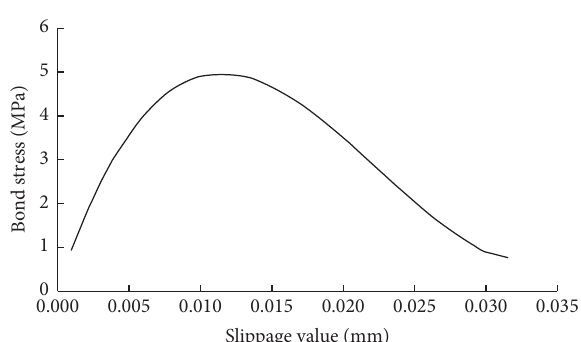
Figure 3: Stress-strain relationship between circular steel bar and concrete.